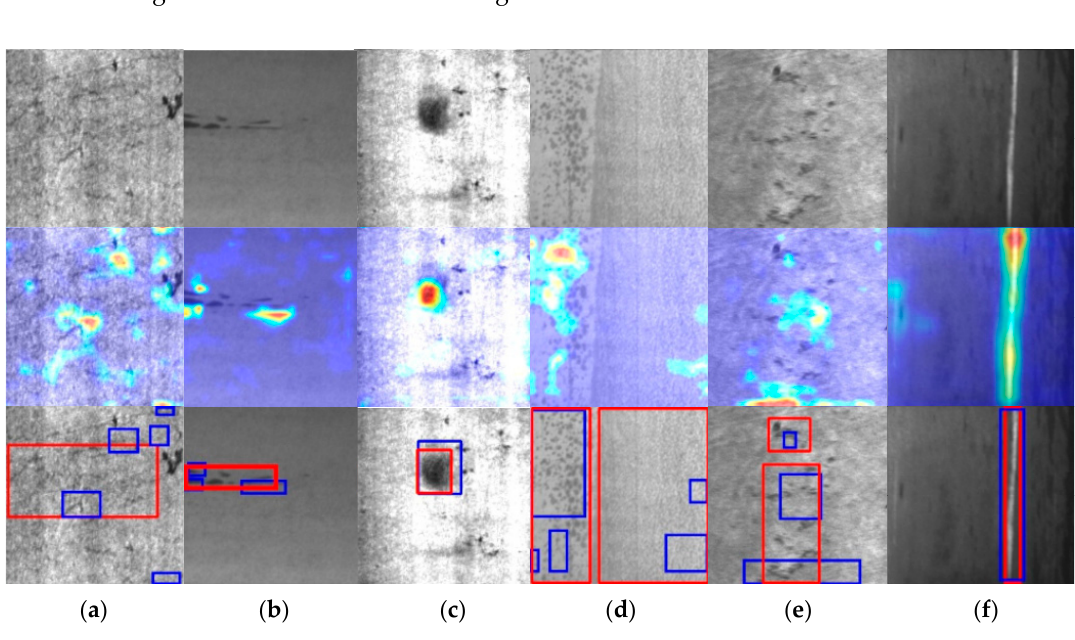
Figure 9. Localization results of the proposed method on the NEU defect dataset. From top to bottom are the original image, the combination of the original image and the heat map, and the location results of the defects. The Ground-Truth of the defect is marked with the red bounding boxes, and the localization results of the proposed method is marked with the blue bounding boxes. ( a ) crazing; ( b ) inclusion; ( c ) patches; ( d ) pitted-surface; ( e ) rolled-in-scale; ( f ) scratches.